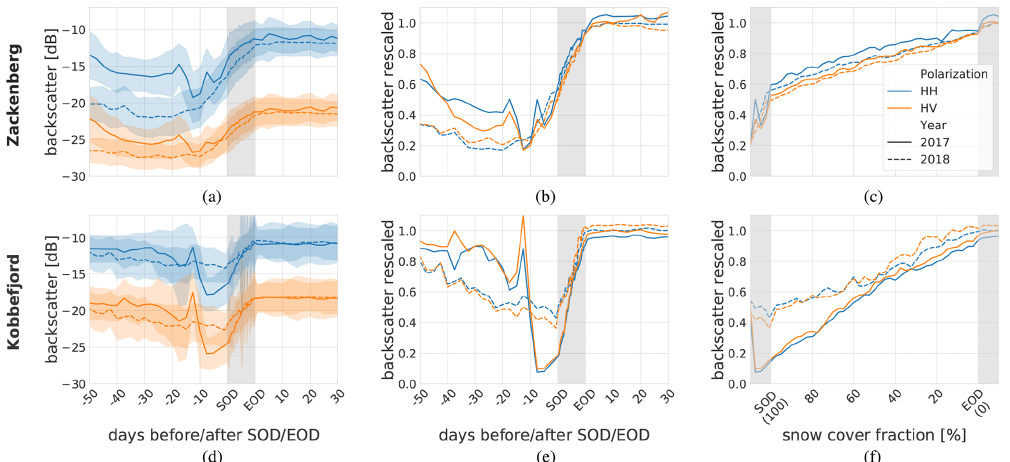
Figure 7. Development of Sentinel-1 backscatter intensity over the melting season compared to same-day snow cover (SC) fraction from orthorectified time-lapse imagery (SC_Fraction DOY ) for ZRA (a–c) and KRA (d–f) . Negative days indicate the number of days before the first observable decrease in SC fraction (SOD – start of decrease). Positive days indicate the number of days after the observed snow cover fraction has reached 0% (EOD – end of decrease). The x -axis range (grey area) between SOD and EOD in panels (a, d) and (b, e) is modified to the observed average period between these dates (10d) and does not represent the actual time range. (a, d) Seasonal development of absolute backscatter intensities ( γ 0 ) with standard deviation and (b, e) of rescaled intensities (0: seasonal backscatter minimum min (γ 0 ) ; 1: mean snow-free summer backscatter intensity). (c, f) Close view of the development of rescaled backscatter between SOD and EOD during the decrease in SC